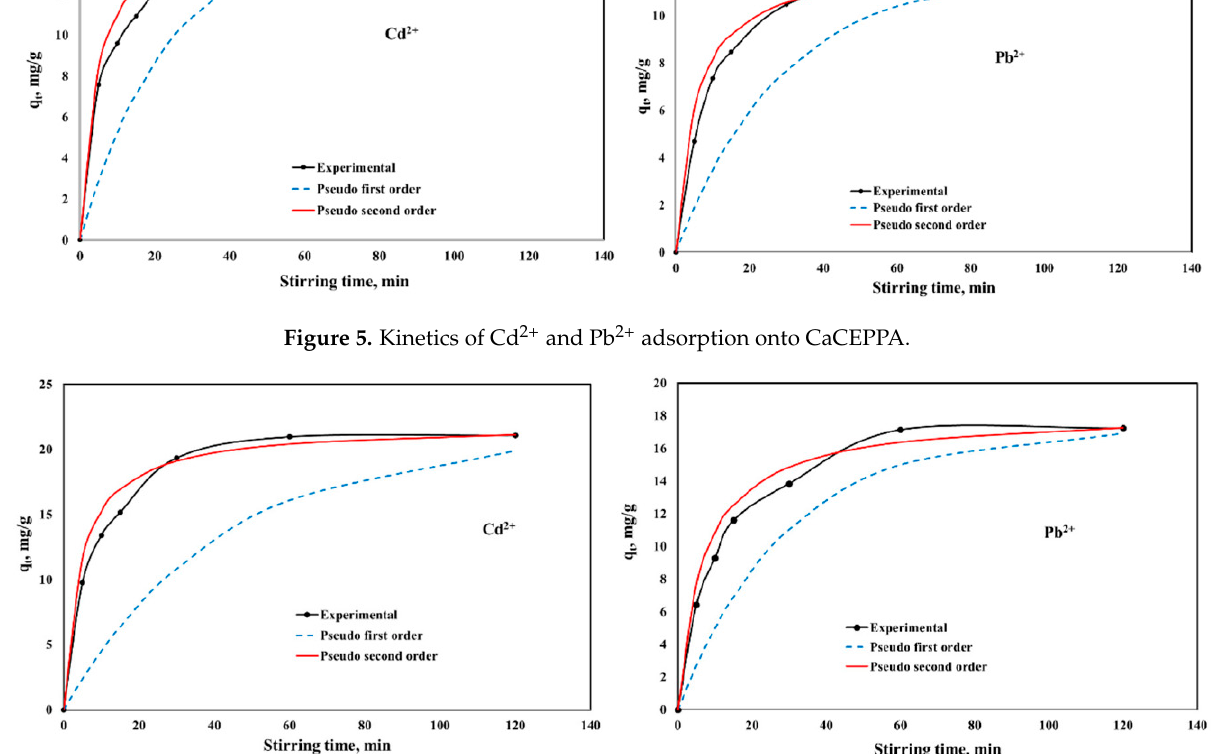
Table 1. Pseudo-first-order and pseudo-second-order kinetic parameters for Cd 2+ and Pb 2+ adsorption from aqueous solutions onto CaCEPPA and CoCEPPA materials.